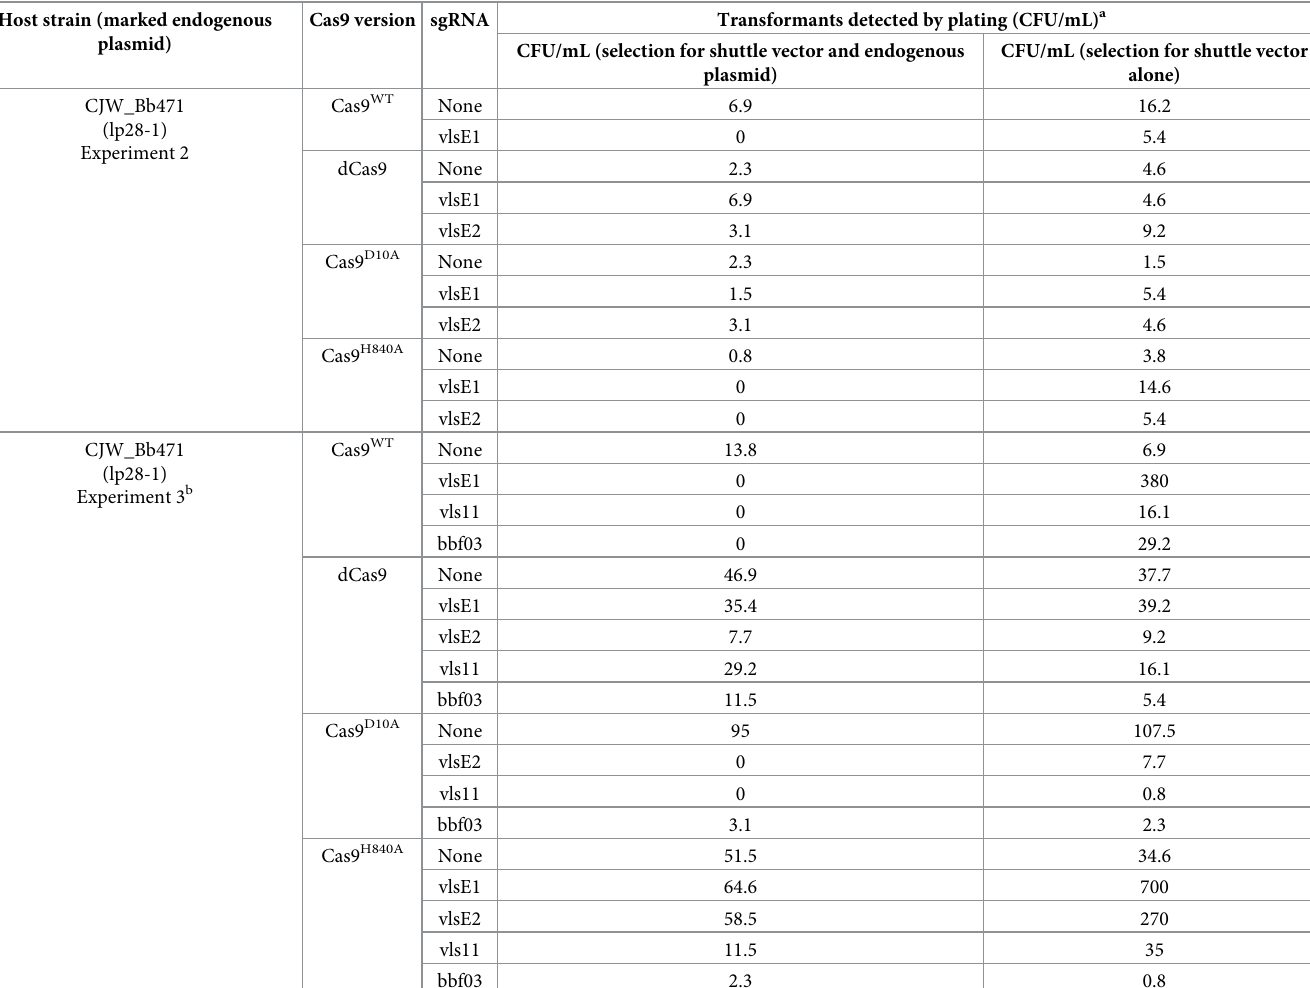
Table 6. Linear plasmid 28–1 (lp28-1) retention in B . burgdorferi following Cas9 targeting, as detected by plating. Host strain (marked endogenous